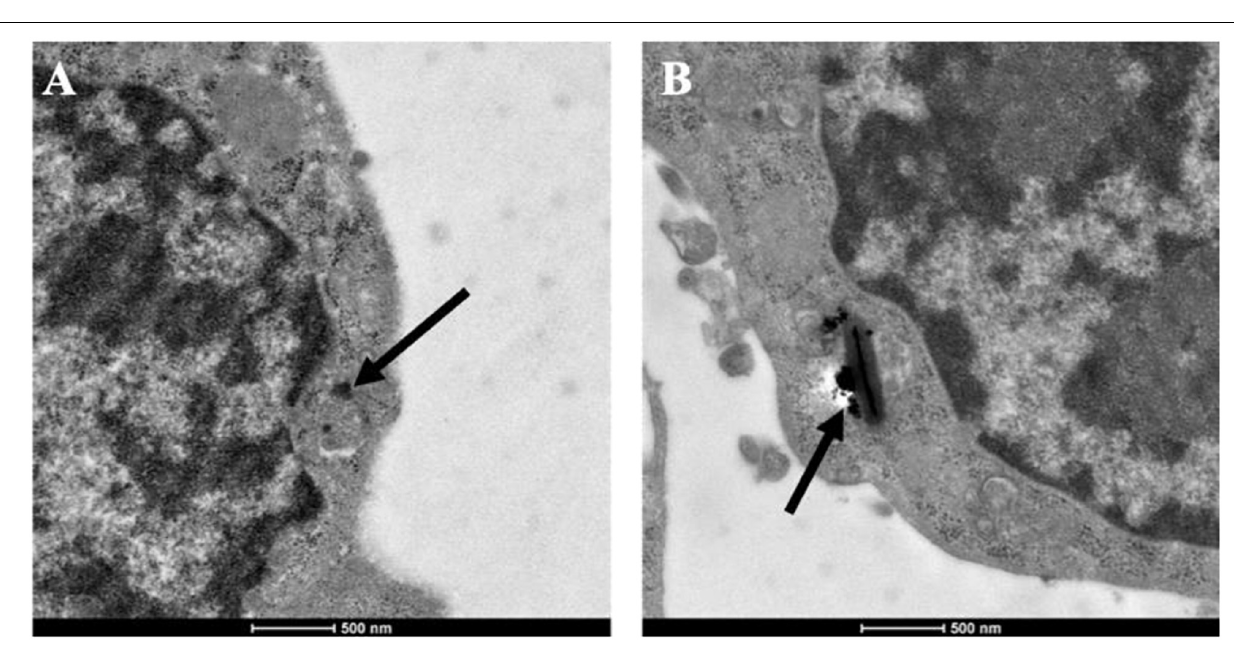
FIGURE 2 | Representative of TEM images of Raw264.7 co-incubated with CuBiS 2 NPs. Scale bar: 500 nm. (A,B) Macrophages incubated with 160 mg/mL CuBiS 2 NPs for 6 and 12 h, respectively. Scale Bar: 500